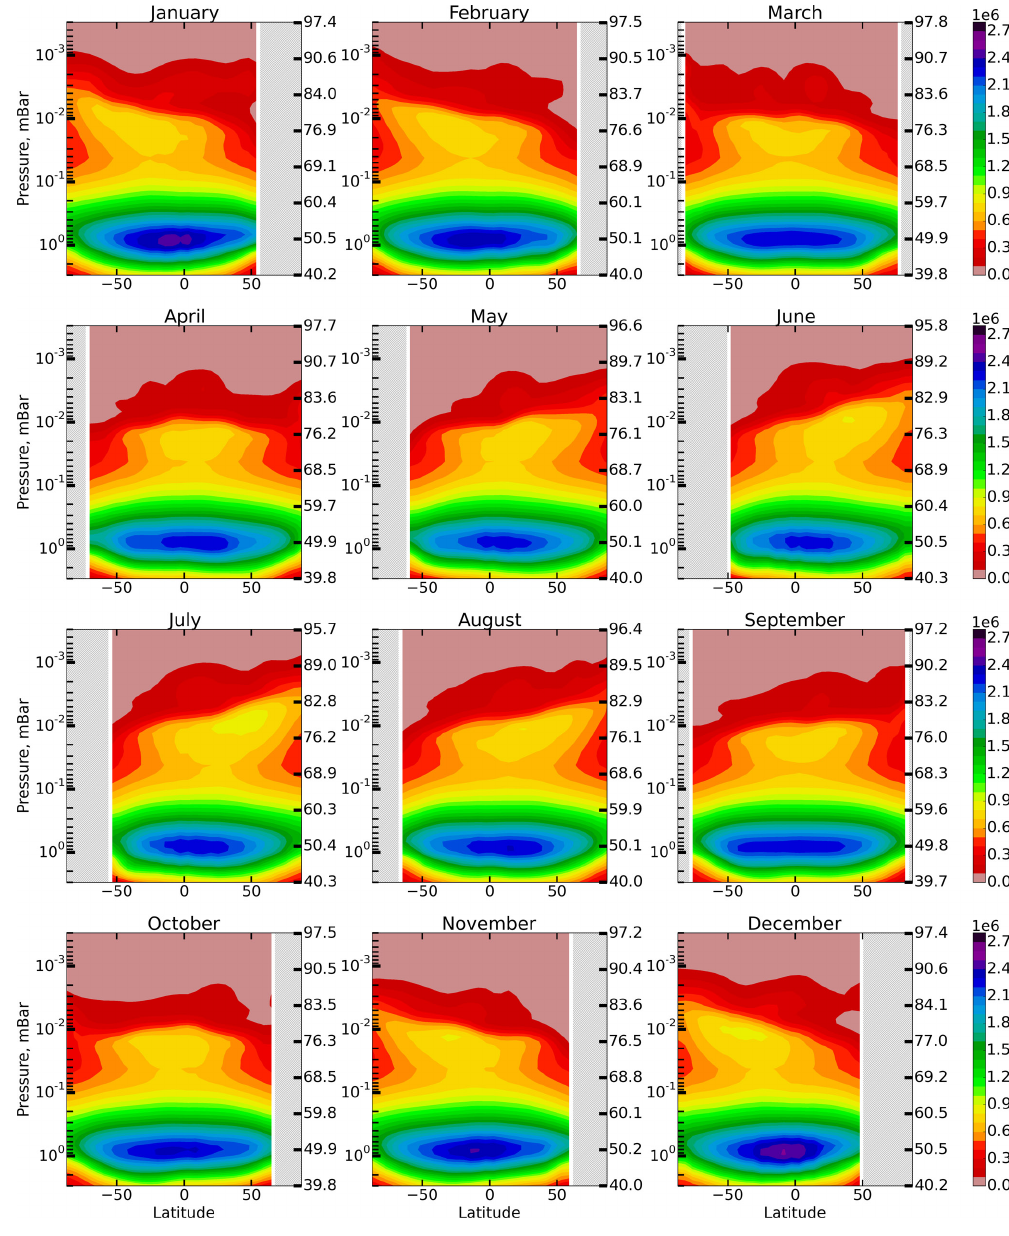
Figure 2. Daytime monthly averaged zonal mean P OH distributions (in cm − 3 s − 1 )